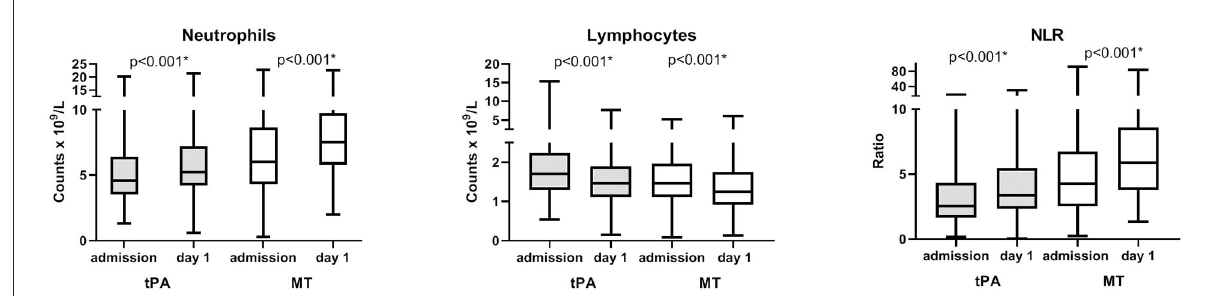
FIGURE2 Longitudinal changes of neutrophil, lymphocyte counts, and neutrophil-to-lymphocyte ratio (NLR) over time. Analysis of repeated measures of neutrophil, lymphocyte counts, and NLR at admission and at day 1 in patients with both admission and day 1 complete blood counts available ( n = 495 in tPA and n = 295 in MT). P -value refer to comparisons of repeated measures. Boxes, 25–75% interquartile range; central horizontal bars, median; outer horizontal bars, minimum and maximum values. Significant ( P < 0.001) differences between admission and day 1 values were also obtained in comparisons of means (Mann–Whitney U -test) on the entire population (data not shown). IVT, intravenous thrombolysis; MT, mechanical